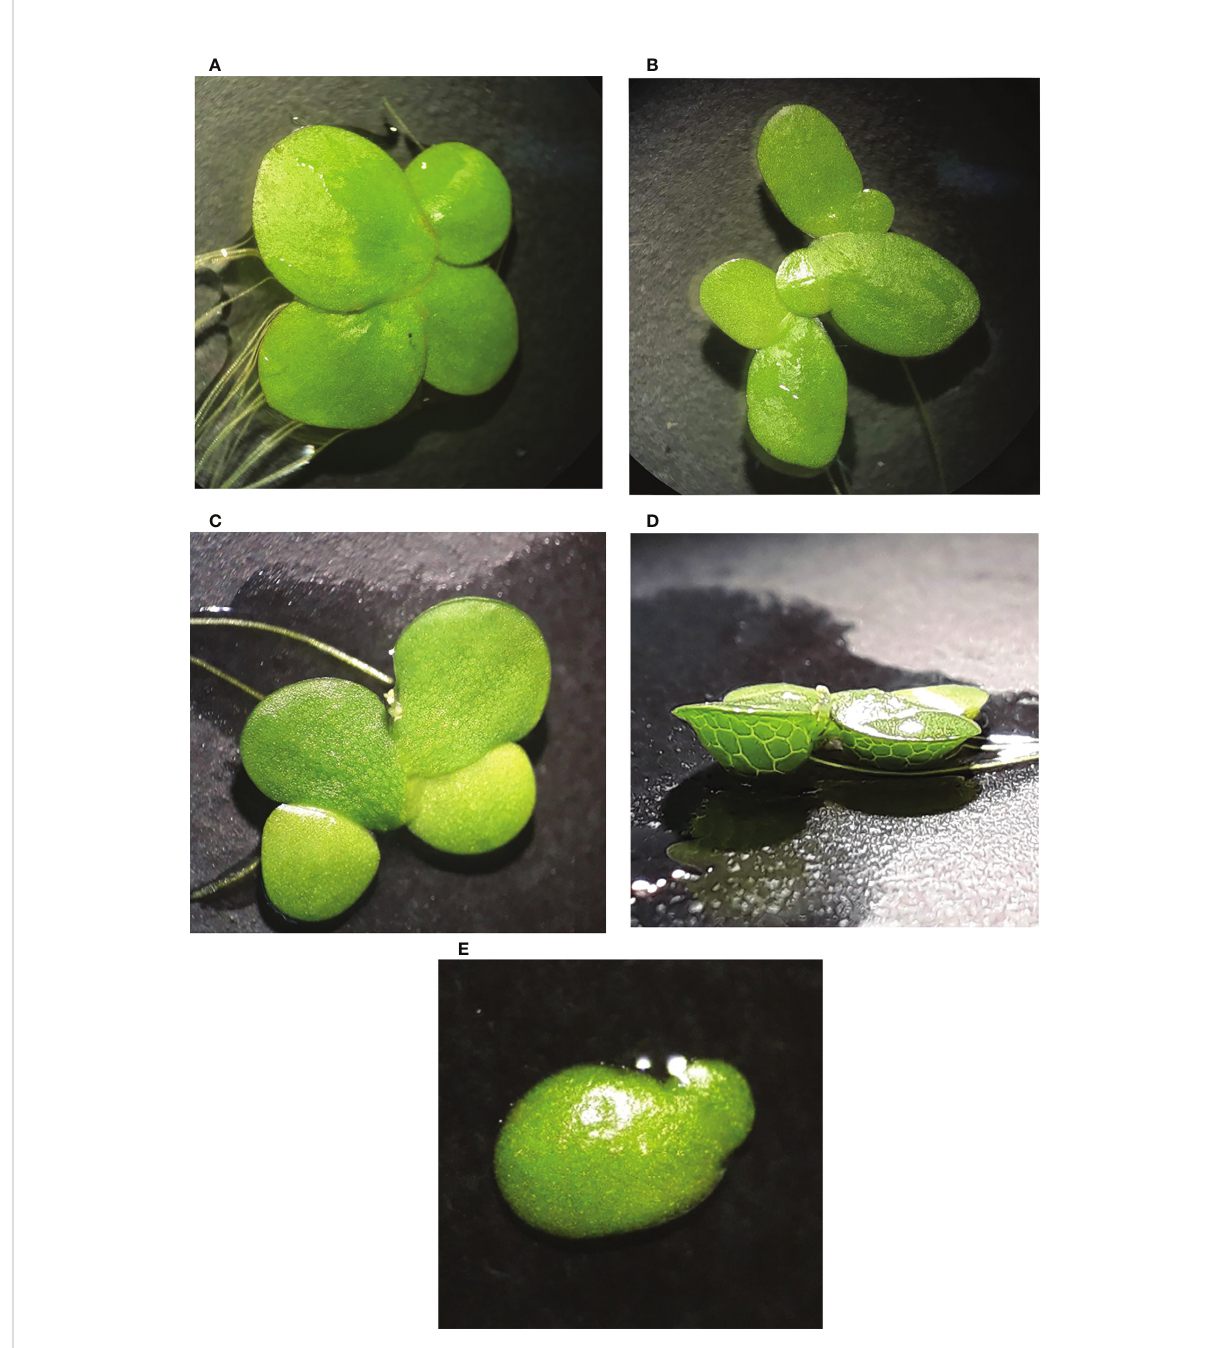
FIGURE 1 Four investigated duckweed species native to Iran; (A) Spirodela polyrhiza. (B) Lemna minor. (C) L. gibba in dorsal view. (D) L. gibba in ventral view. (E) L. turionifera